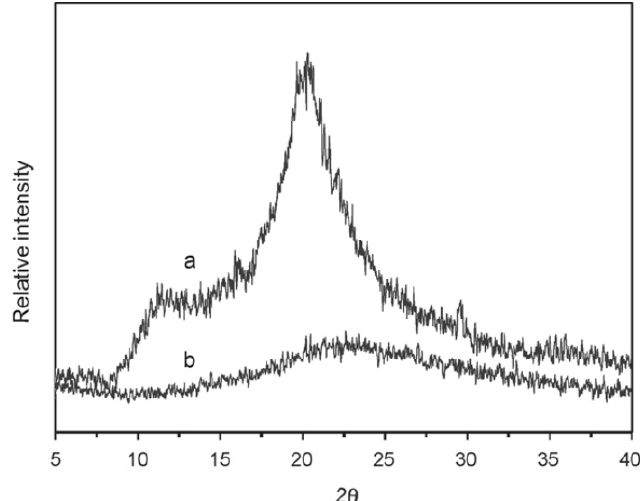
Figure 17. XRD patterns of ( a ) pure chitosan and ( b ) chitosan in non-supported hybrid material. Reprinted with permission from [239]. Copyright 2007